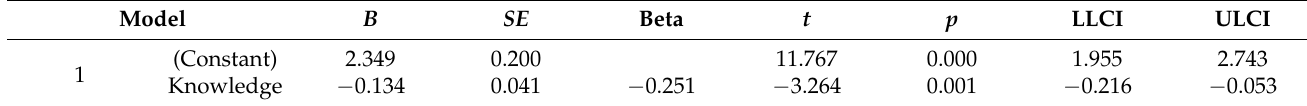
Table 4. Coefficient of the prediction of COVID-19 knowledge on COVID-19-related anxiety.